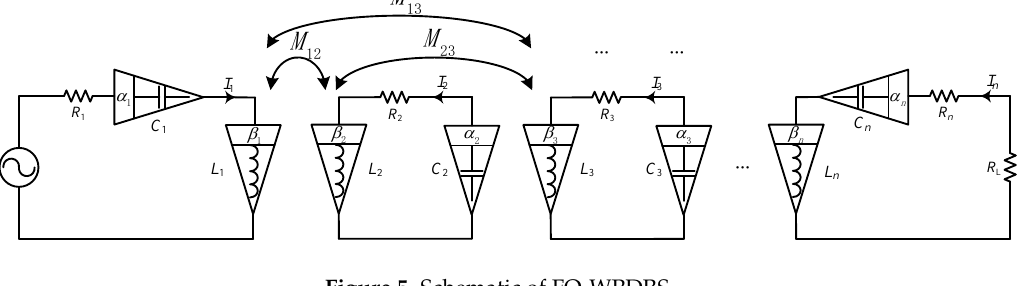
Figure 5. Schematic of FO-WPDRS.